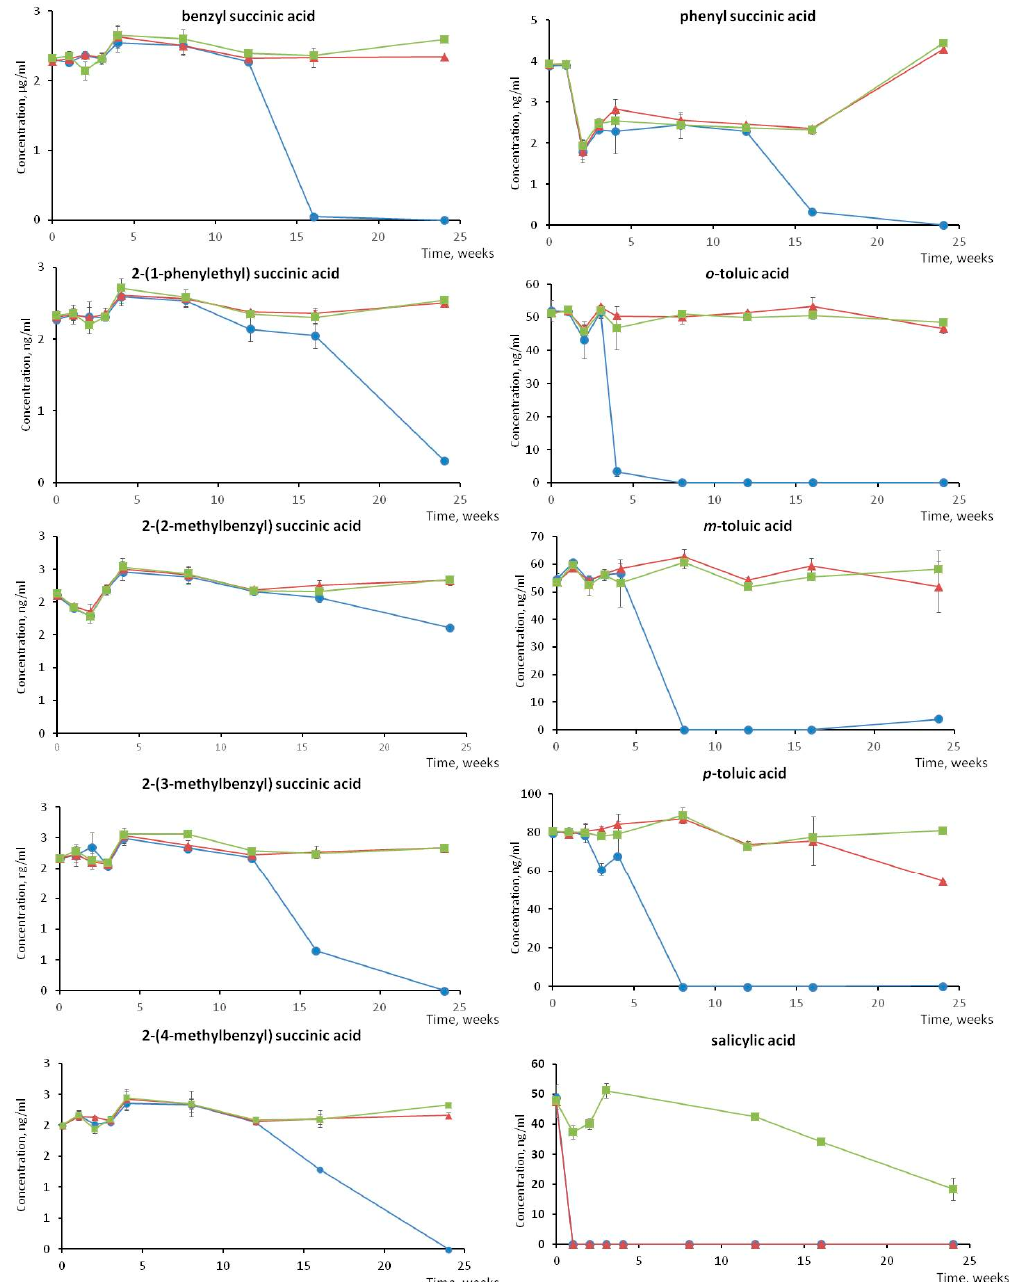
Figure 3. Evolution of the concentration of benzene, toluene, ethylbenzene, and andxylenes (BTEX) metabolites during sample storage at room temperature (blue curve), 4 °C (red curve) and − 20 °C (green curve) over 24 weeks (deep gas storage aquifer water spiked with known initial concentration for the purpose of a stability study).